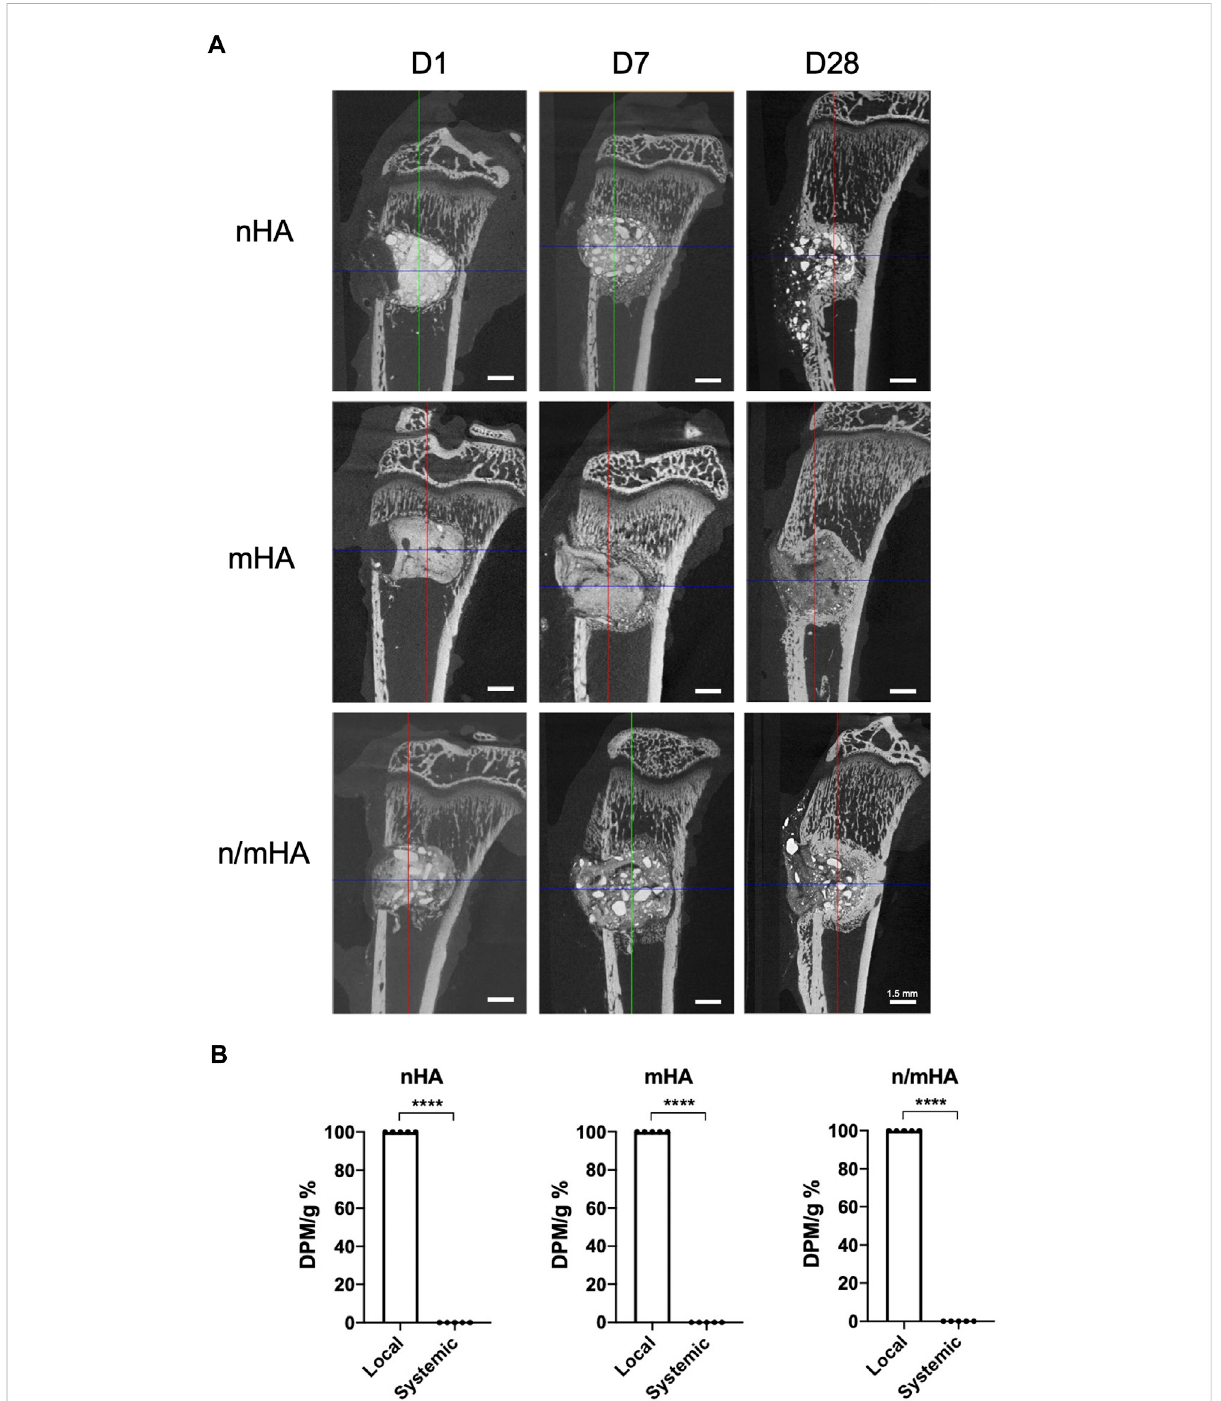
FIGURE 4 The local distribution of HA particles and its comparison to the amount of HA particles migrated systemically to vital organs. (A) Shows the micro-CT images of the local distribution of implanted HA particles in the proximal tibial over a course of 28 days (B) Shows the difference of detected radioactivity between the proximal tibia (local) and vital organs (systemic). **** indicates p <